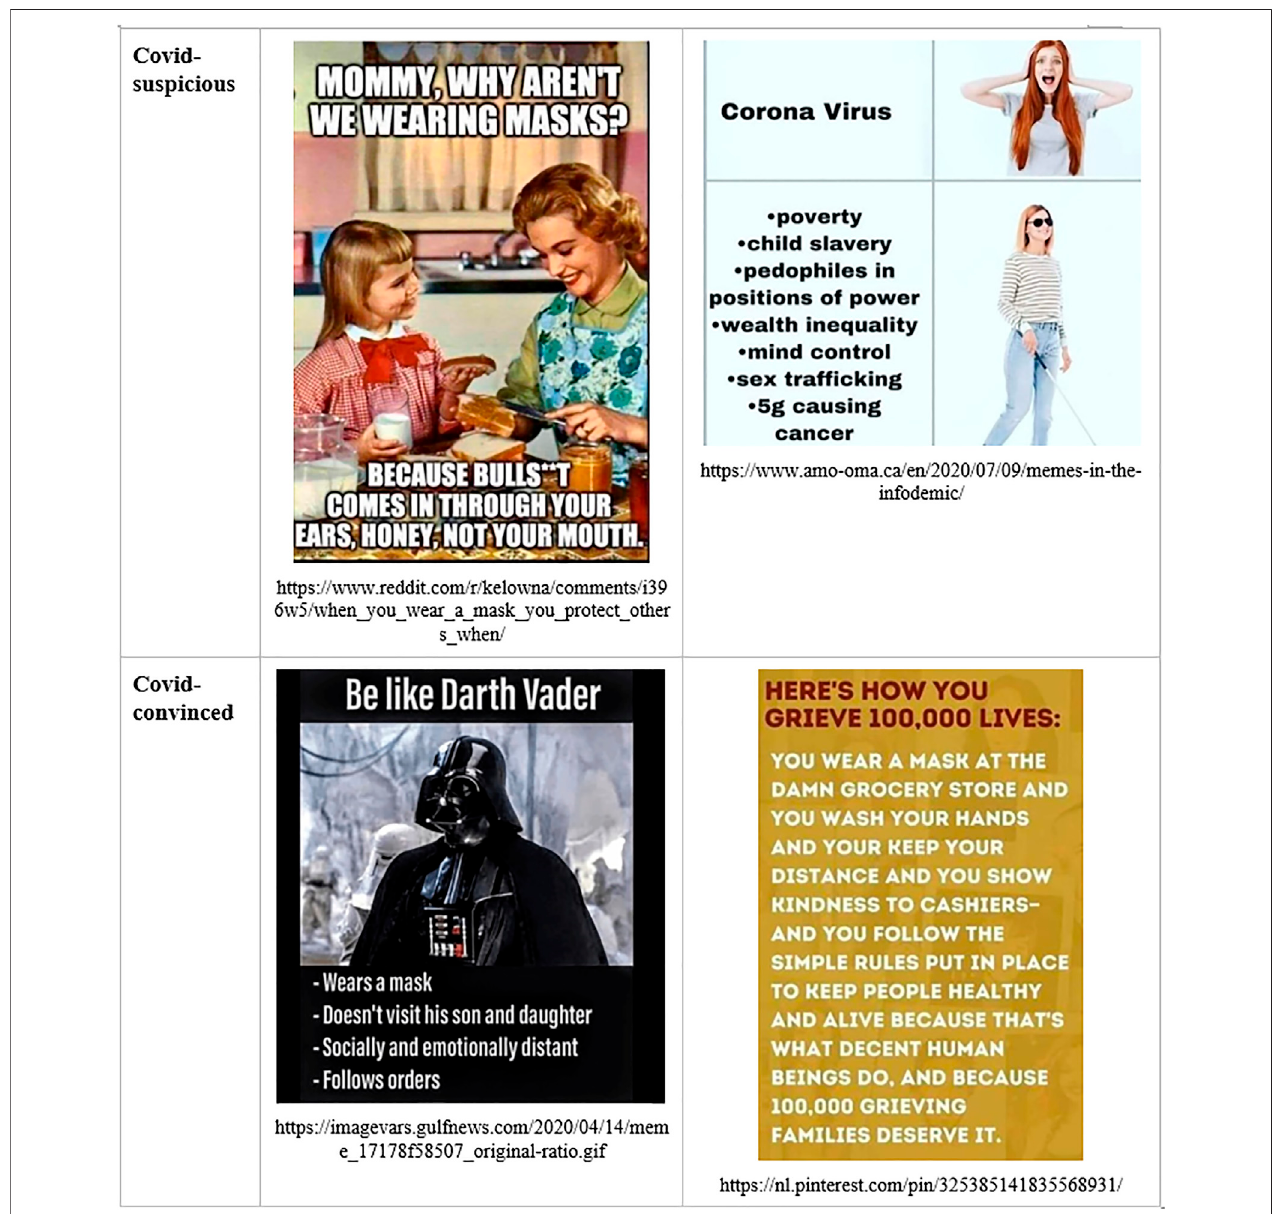
FIGURE 8 | Emotion work in covid-skeptical and covid-anxious memes.